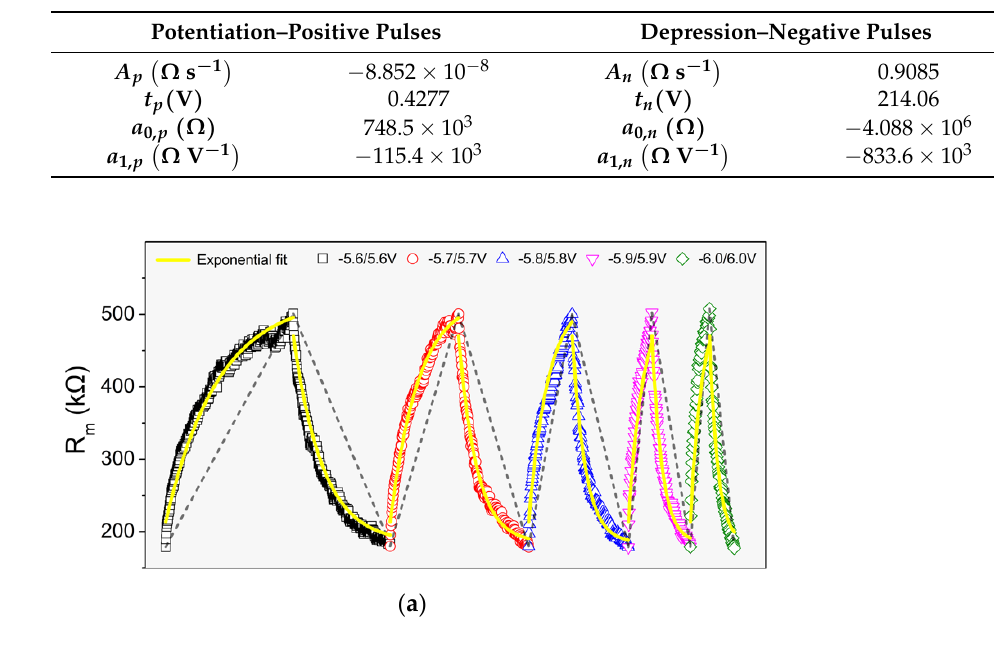
Table 1. Fitting values for the exponential windowed model.